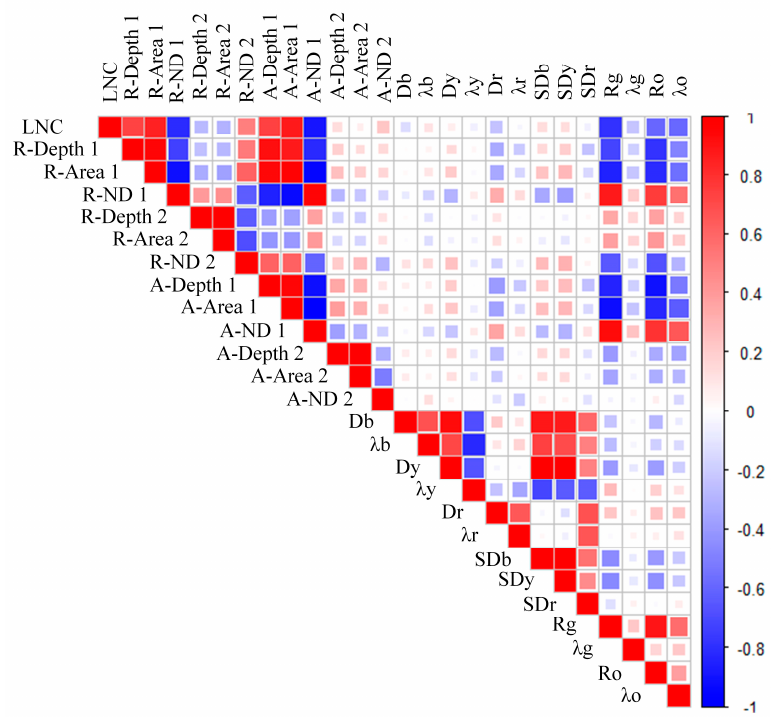
Sensors 2021 , 21 , x FOR PEER REVIEW